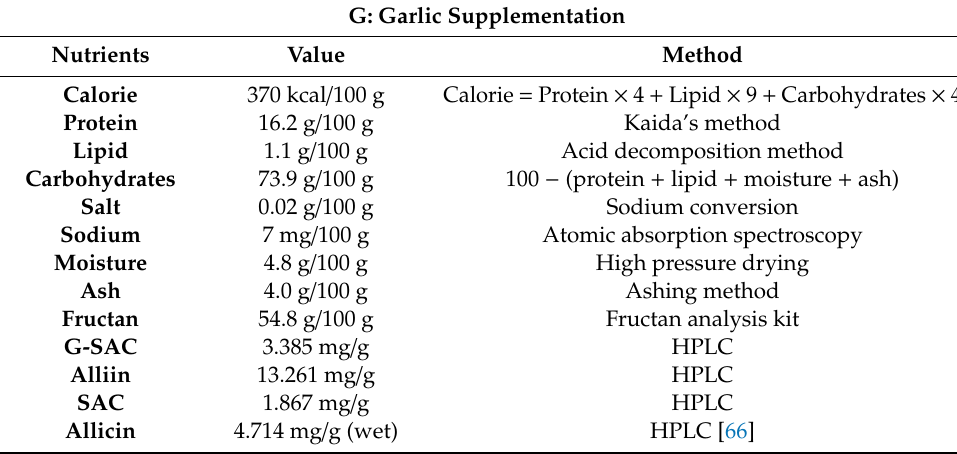
Table A1. Nutrient analysis. G: Garlic